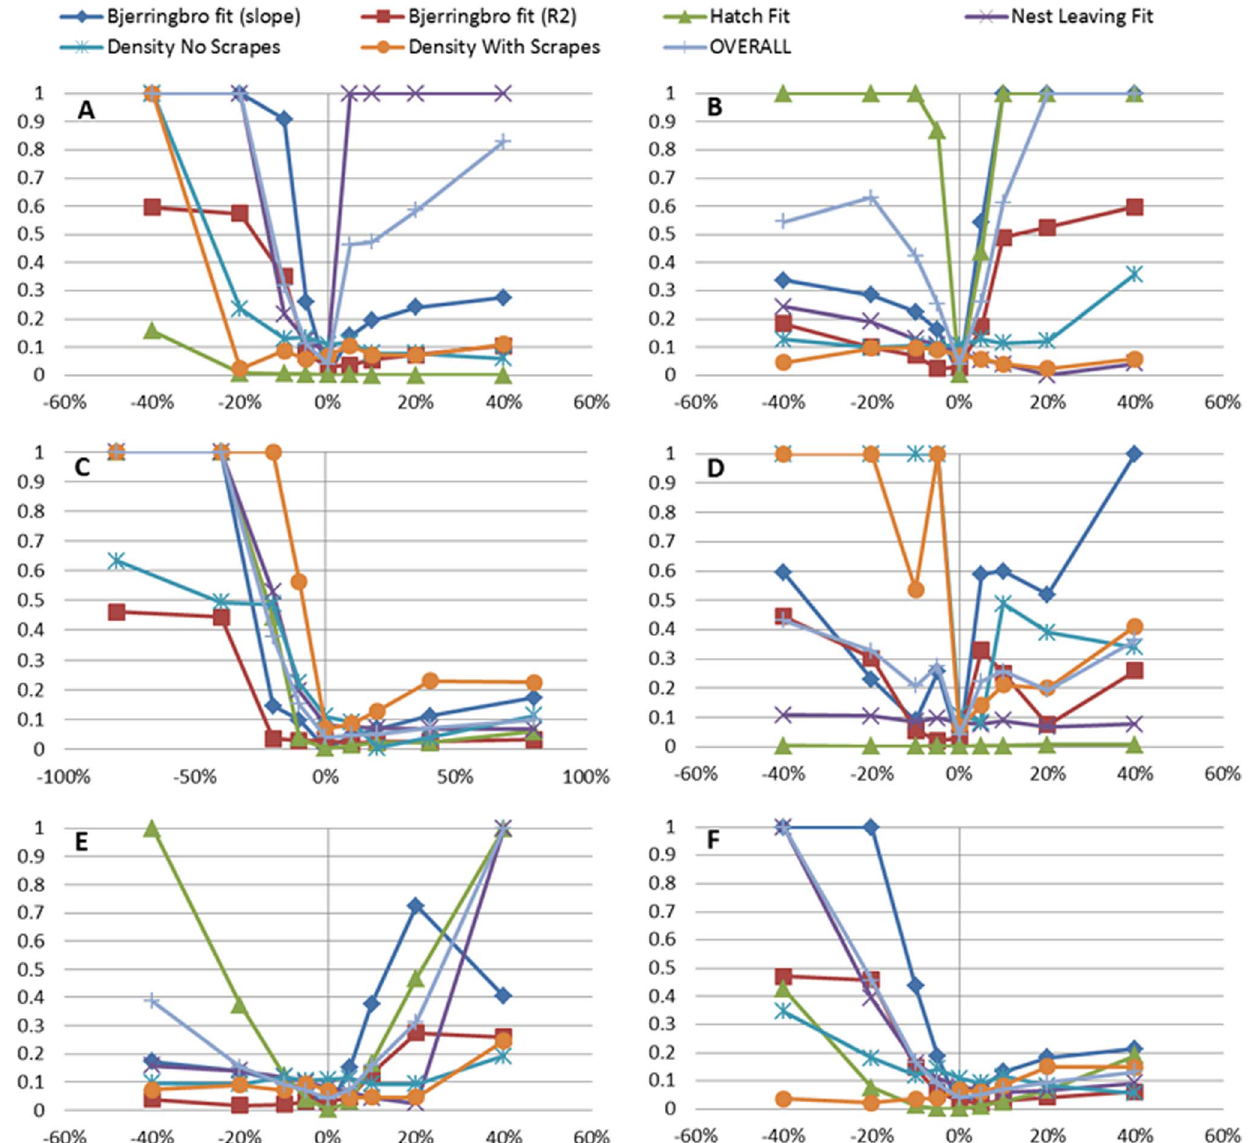
Figure 6. Parameter sensitivity for the six most sensitive parameters using 7 fit statistics. Each panel represents the deviation in model output relative to field data for particular parameters. Each point represents the deviation of model output from the corresponding field data pattern averaged across replicates. Each line in each panel represents the response to variation ( 6 5, 10, 20, and 40%) in one particular parameter; hence lines of the same colour come from the same simulations and can be directly compared between panels. The parameters presented are: maximum daily growth rate of nestlings PEMAX (A), minimum incubation time MINDAYSTOHATCH (B), threshold for reduction in habitat quality due to increasing vegetation density DENSITYCONST_C (C), minimum habitat score for female acceptance of a territory MINFEMACCEPTSCORE (D), the threshold for physiological development of eggs MD_THRESHOLD (E), and food extraction rate EXTRACTION_RATE (F).